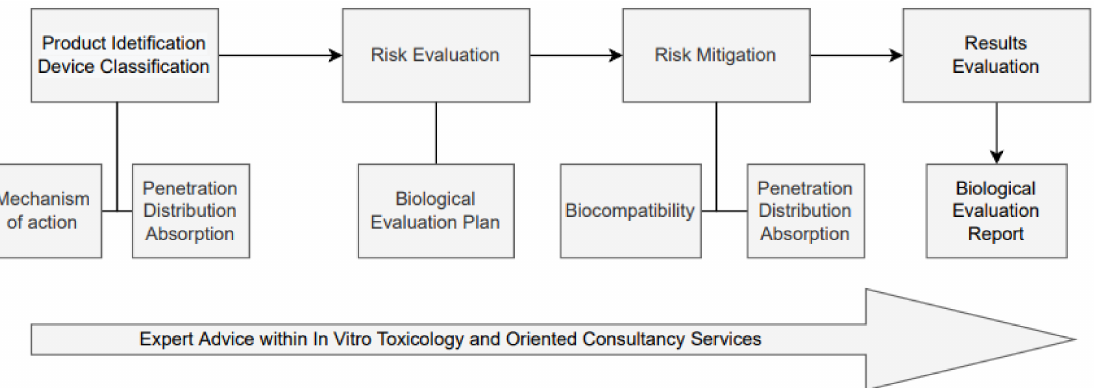
Figure 3. Steps that are mandatory to bring a potentially innovative biomaterial technology to an implantable